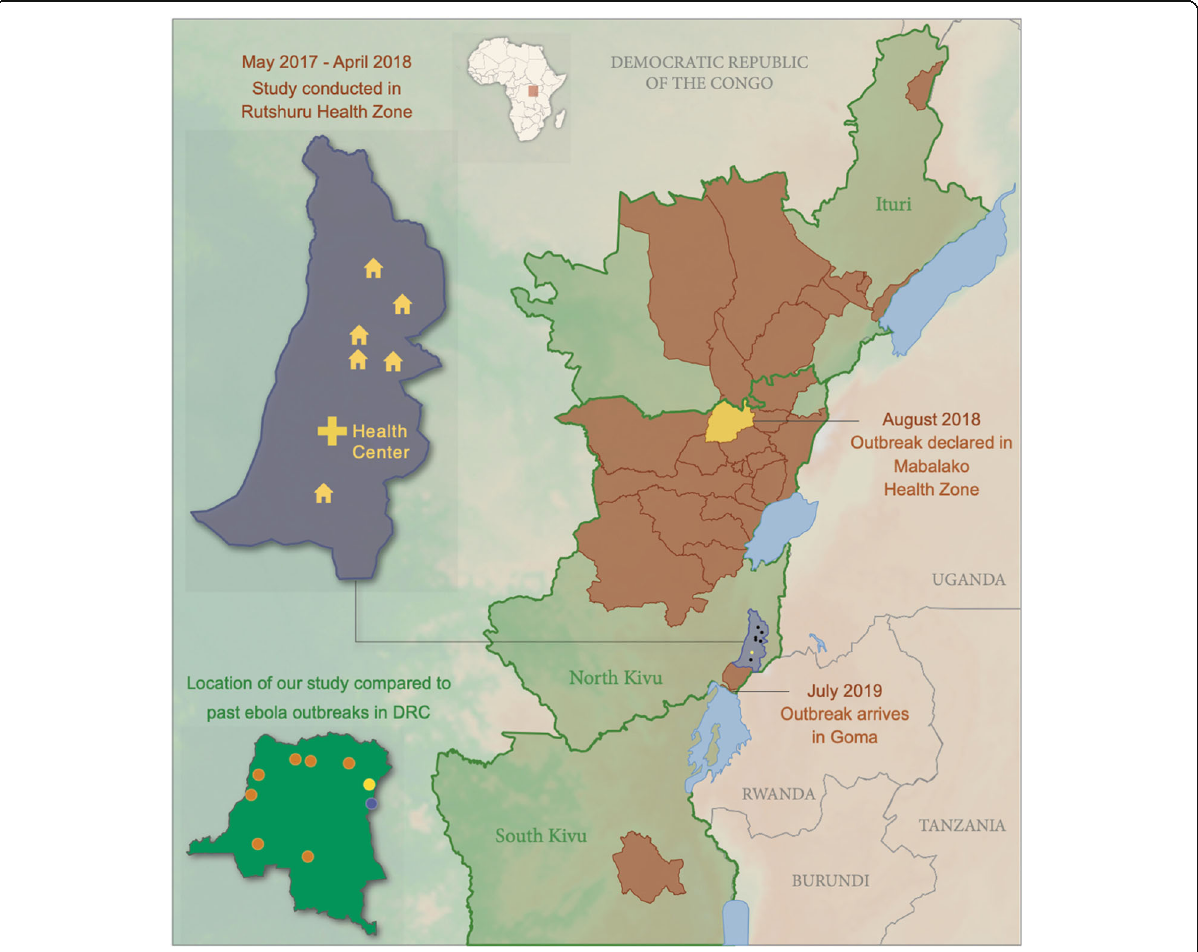
Fig. 1 Location of villages and the Rubare Health Center in Rutshuru Health Zone, North Kivu Province where febrile study participants traveled from and were treated prior to Ebola Virus Disease outbreak in Eastern DRC that began in 2018. The outbreak was first observed in the Mabalako Health Zone (yellow) in North Kivu before spreading to other areas (brown). Inset map of the DRC: Location of the 2018 – 2020 outbreak (yellow), study location (purple) and other EBOV outbreaks in the DRC to date